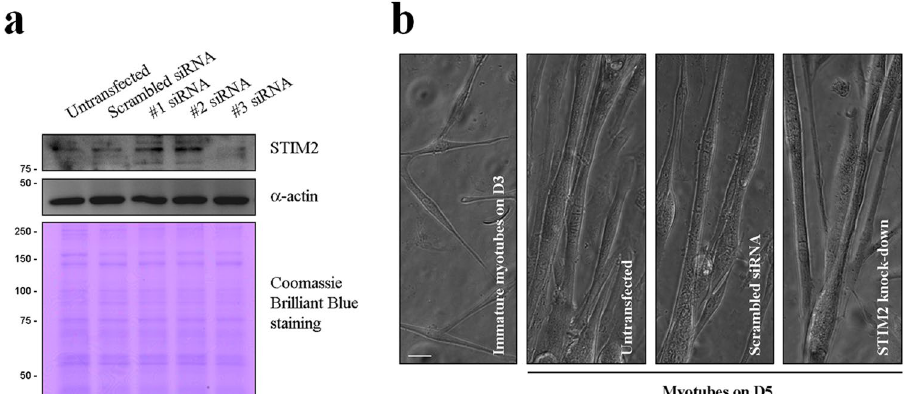
Figure 2. Knockdown of STIM2 in mouse primary skeletal myotubes. ( a ) Three different forms of siRNA were used to knock down STIM2 in mouse primary skeletal myotubes. The lysate of the STIM2-knockdown myotubes (50 μ g of total protein) was subjected to immunoblot analysis with anti-STIM2 antibody (upper panel). α -actin and Coomassie Brilliant Blue staining were loading controls. #3 siRNA knocked down STIM2 more effectively compared with others (up to 90%). Untransfected control and scrambled siRNA-transfected myotubes were used as negative controls. The immunoblot data were cropped from the immunoblot images of different gels and were grouped. The full-length blots are presented in Supplementary Fig. 5. Three independent experiments were conducted. ( b ) The STIM2-knockdown myotubes with #3 siRNA show normal myotube formations, and are indistinguishable from the untransfected or the scrambled siRNA-transfected control. ‘Immature myotubes on D3’ means untransfected immature myotubes on differentiation day 3 (left). ‘Myotubes on D5’ means untransfected, scrambled siRNA-transfected, or STIM2-knockdown myotubes on differentiation day 5. The bar represents 50 μ